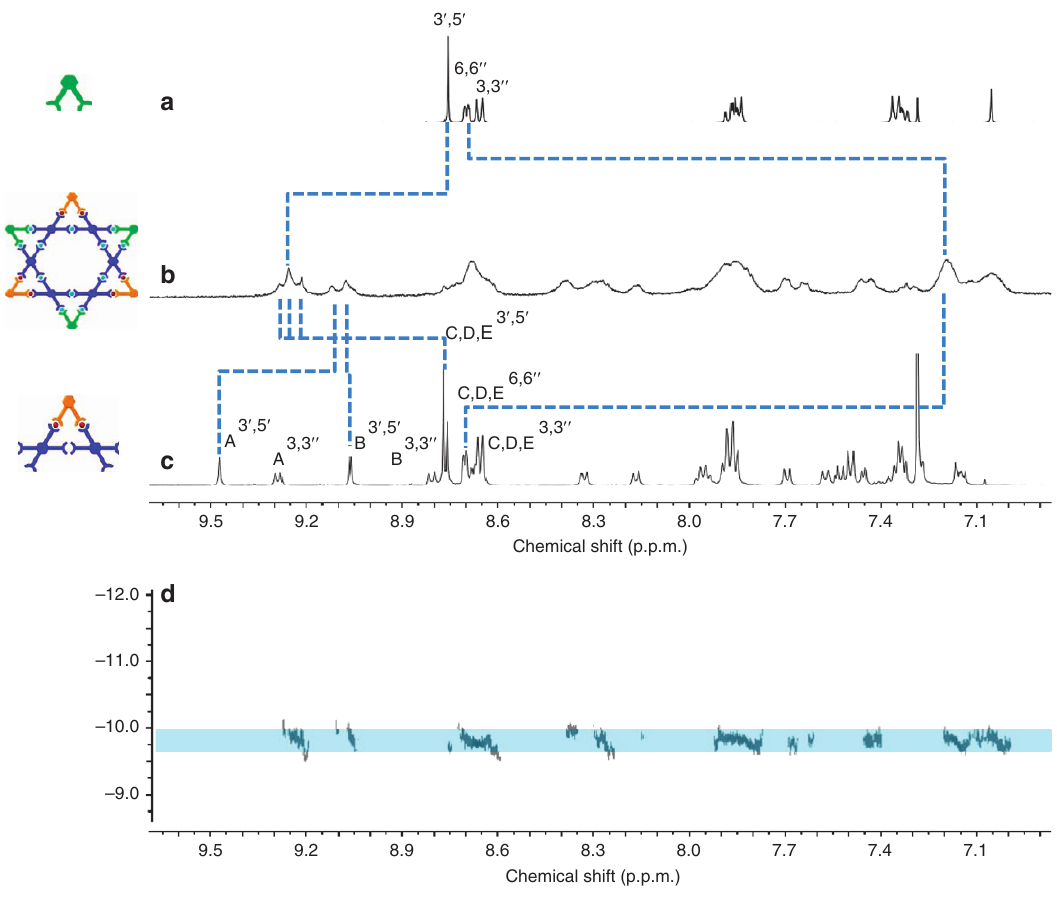
Figure 6 | Comparison of 1 H NMR spectrum. ( a ) bis terpyridine ligand (500MHz, 25 (cid:2) C, CDCl 3 ), ( b ) molecular Star of David [Fe 12 V 3 LB 3 ] (500MHz, 25 (cid:2) C, CD 3 CN), ( c ) metallo-ligand LB (500MHz, 25 (cid:2) C, CD 3 CN) and ( d ) DOSY of [Fe 12 V 3 LB 3 ] (500MHz, 25 (cid:2) C, CD 3